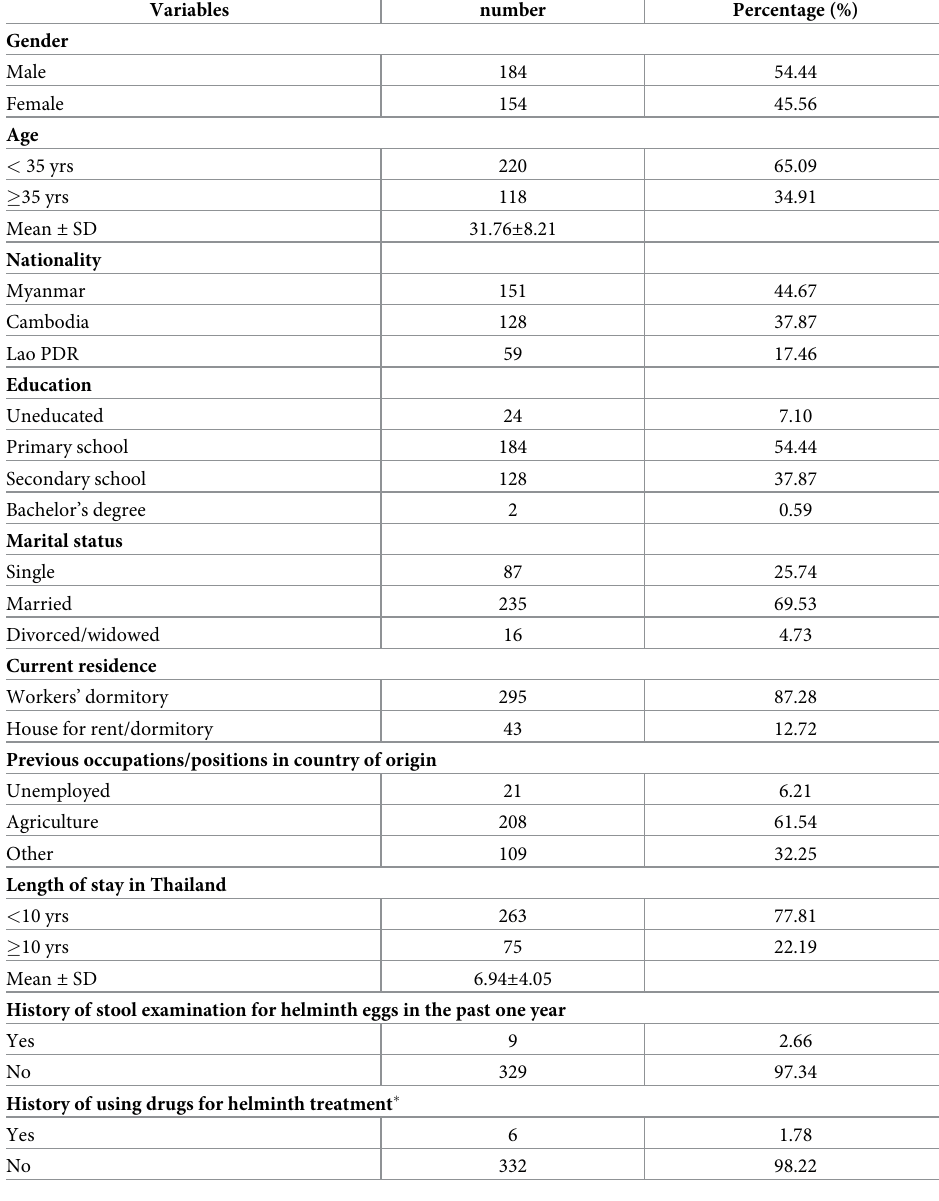
Table 1. Demographic characteristics and socioeconomic status of the participants ( n =